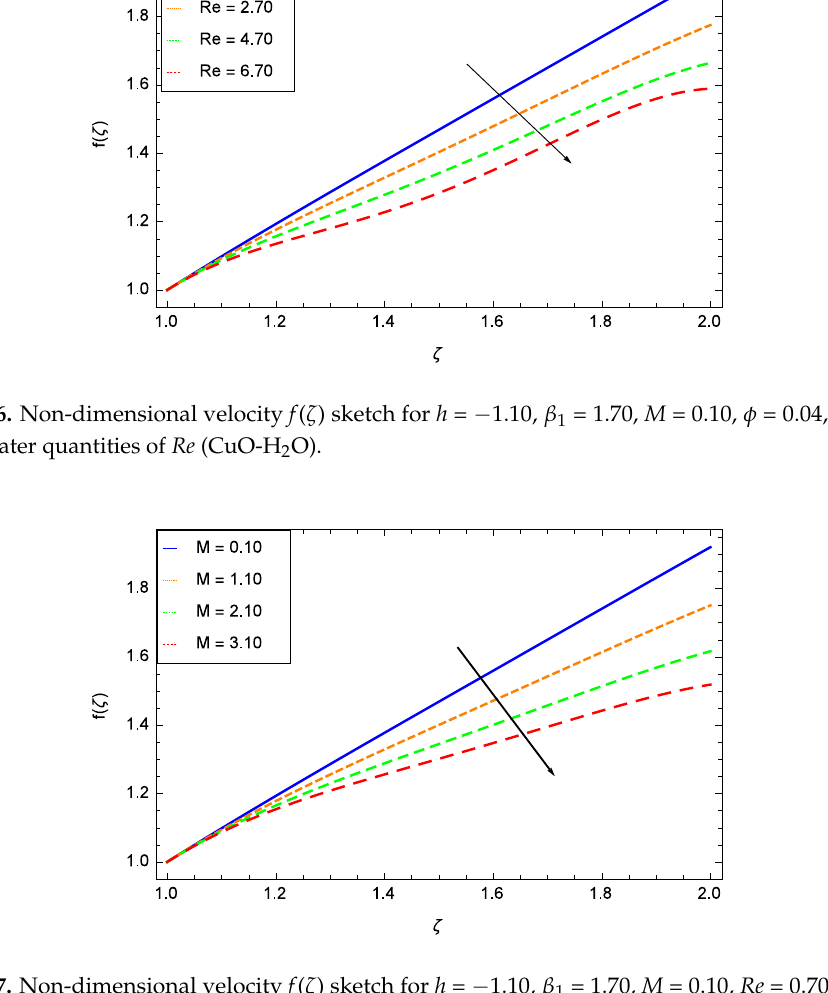
Figure 7. Non-dimensional velocity f ( ζ ) sketch for h = − 1.10, β 1 = 1.70, M = 0.10, Re = 0.70, φ = 0.04, Pr = 6.80 and greater quantities of M (CuO-H 2